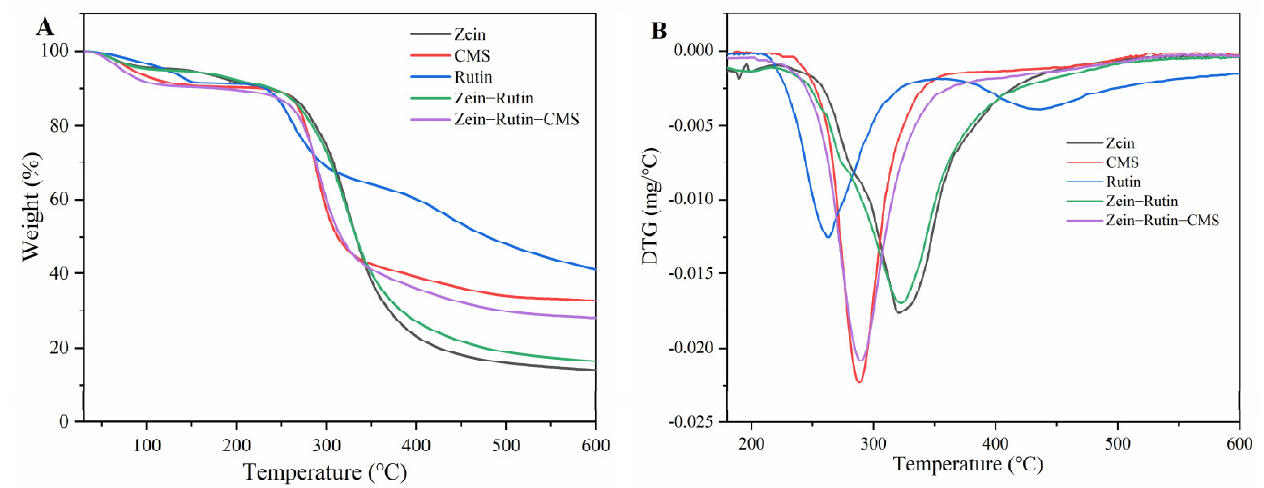
Figure 8. ( A ) TGA spectra of raw materials and composite nanoparticles; ( B ) DTG spectra of raw materials and composite nanoparticles.